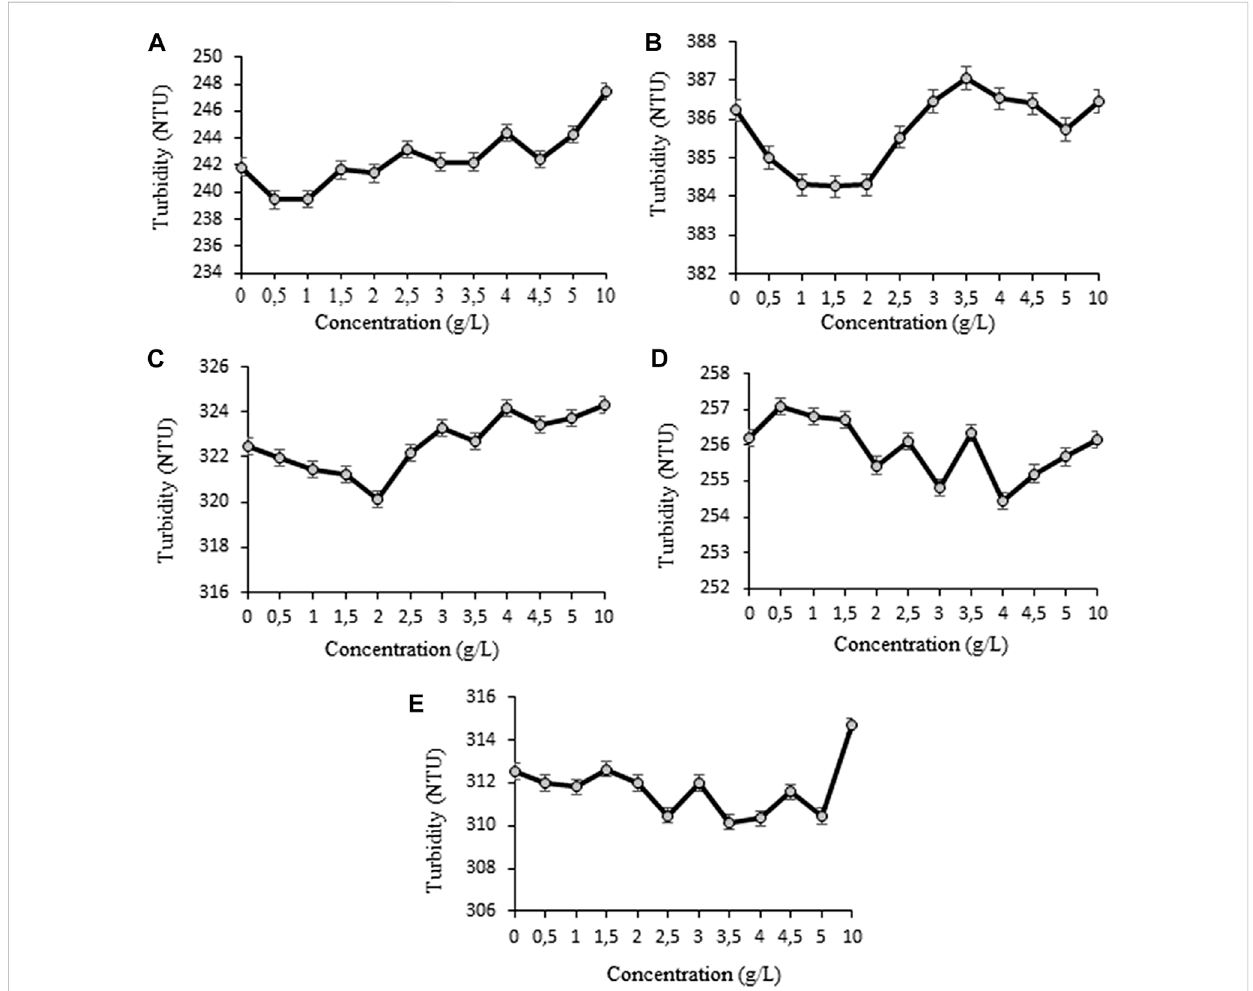
FIGURE 4 Measurementoftheturbidityofwatersamplesafter1 hofdecantationaccordingtotheapplicationofthedifferentplantextracts: Tamarindusindica